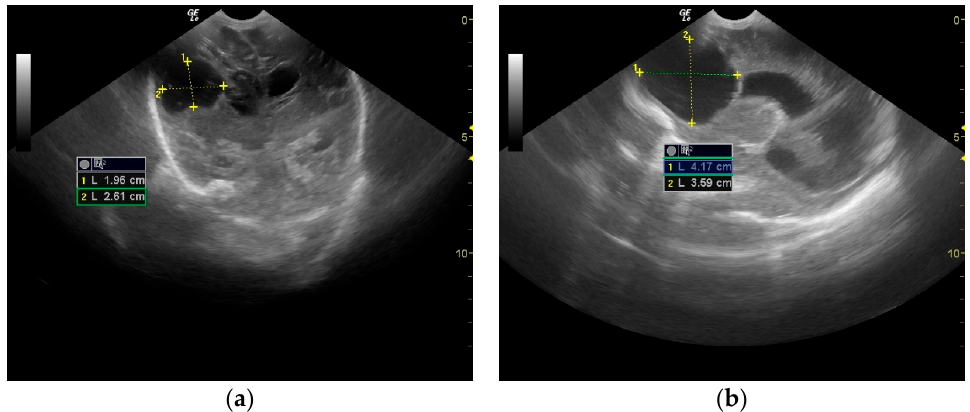
Figure 4. Brain ultrasound on the 30th day of life: cystic cavity (( a ) Frontal coronal plan, ( b ) right parasagi tt al plan).